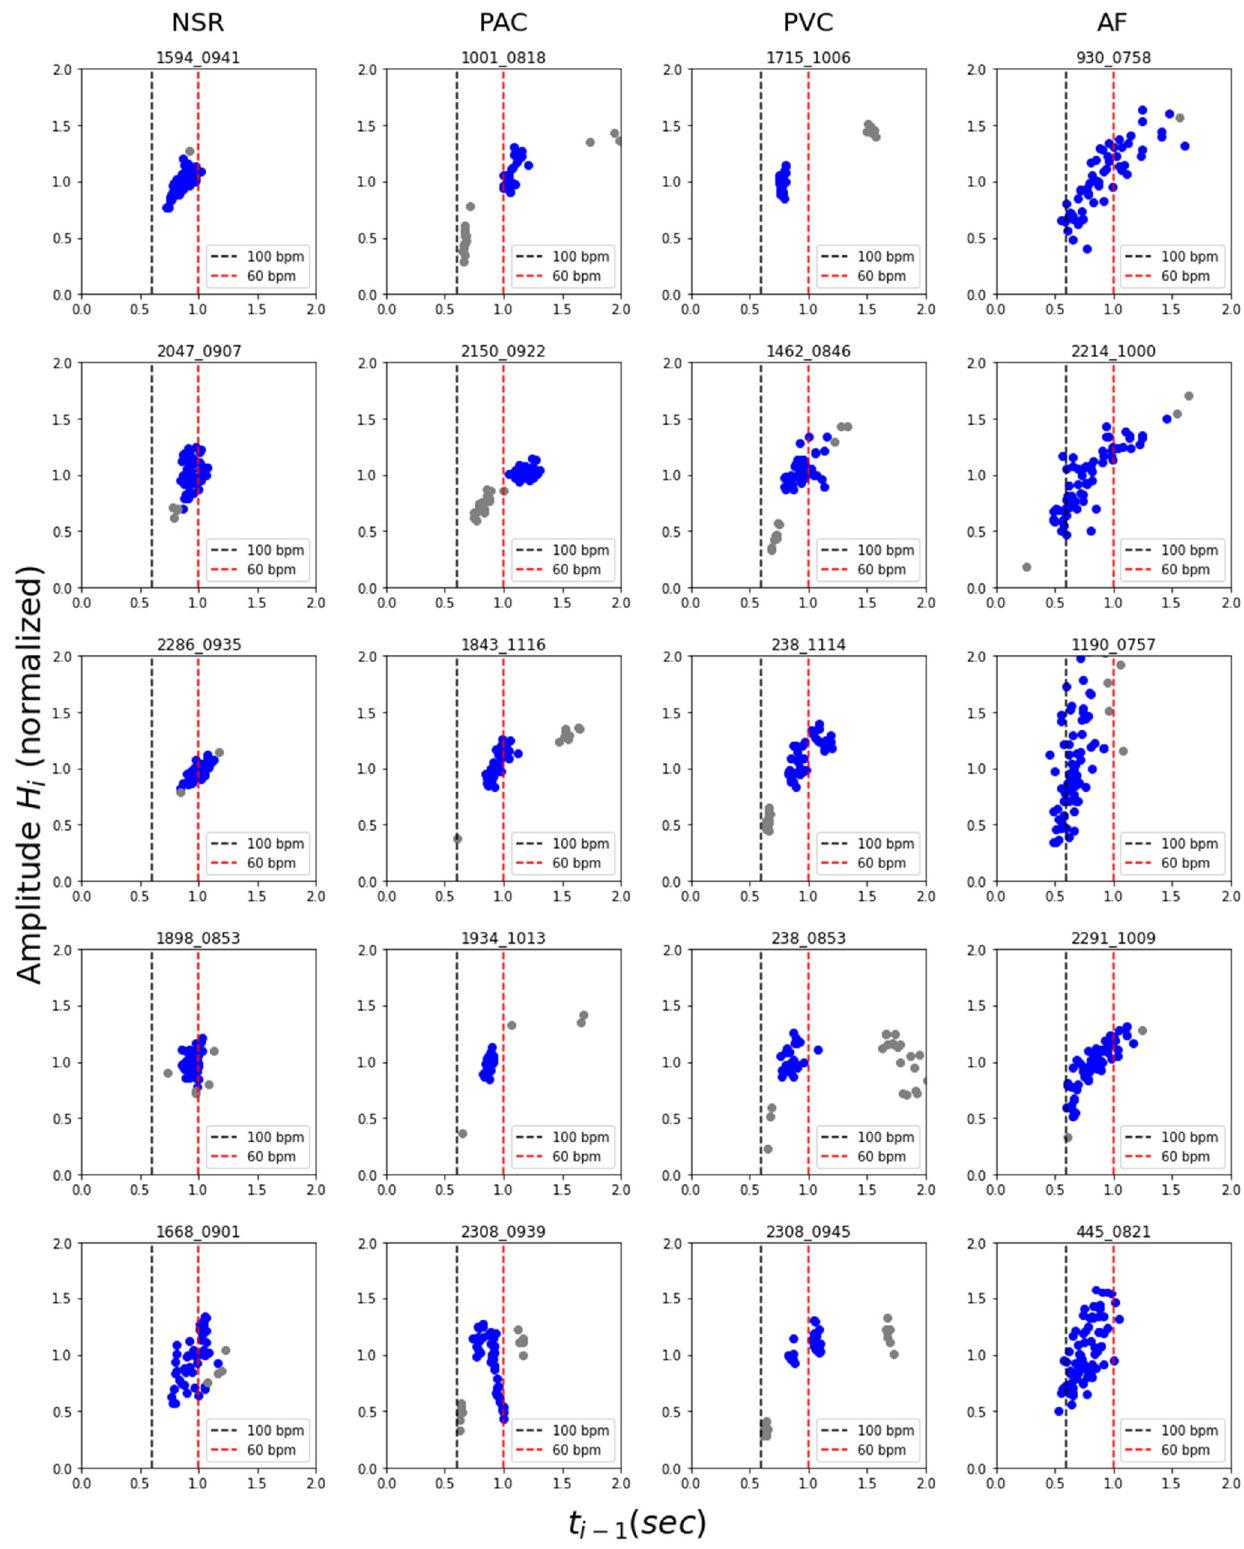
Figure 6. Typical pattern of the flux-interval plot for different cardiac rhythms. Blue dots represent the main cluster for each sample in the plot. ( a ) Flux-interval plot in the configuration of H i vs. t i , ( b ) flux-interval plot in the configuration of H i vs. t i − 1 .